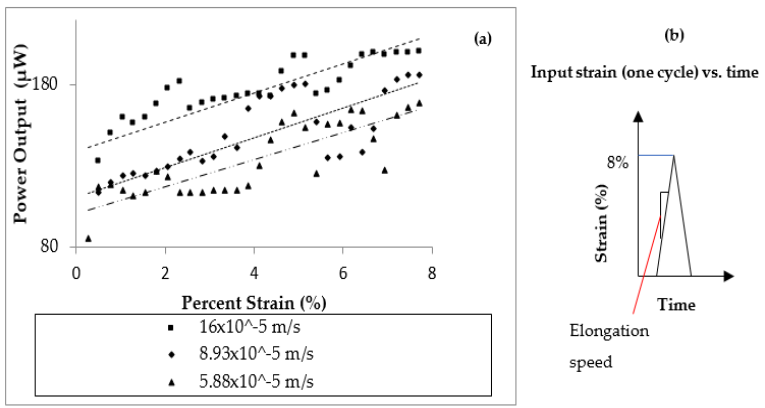
Figure 8. Power output versus elongation speed (m/s). ( a ) Three different elongation speeds were chosen. It was demonstrated that the highest elongation speed will provide the higher power output. ( b ) Explanation of the elongation speed. The device was elongated at the maximum strain of 8% with three different values of the speed.